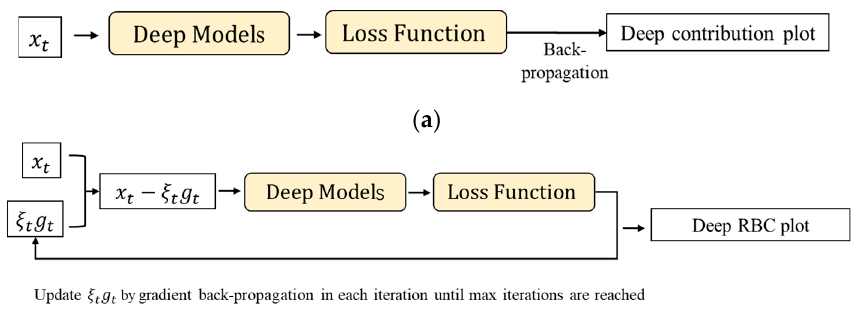
Figure 3. Flowcharts for ( a ) the deep contribution plot and ( b ) the deep reconstruction-based contribution plot.